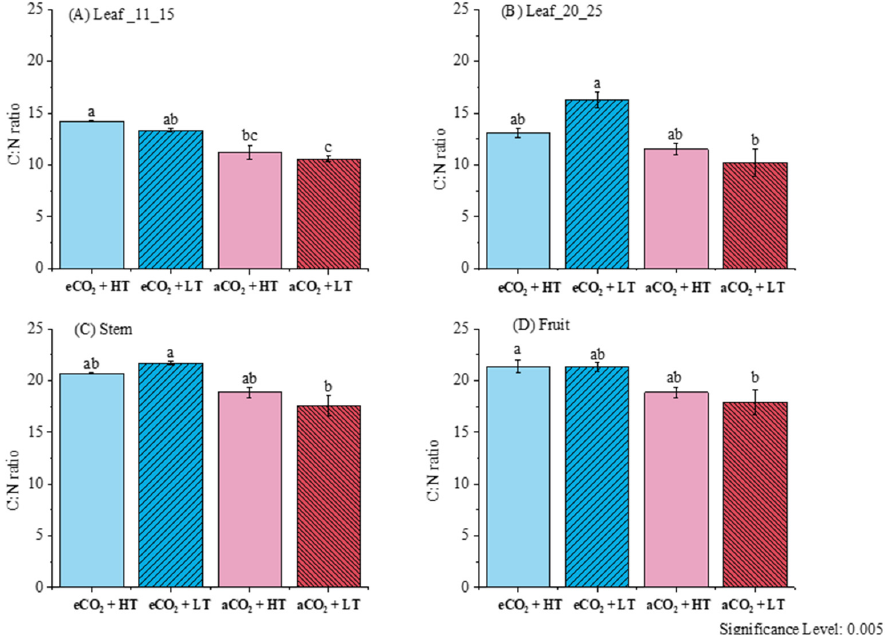
Figure 8. Average C:N ratios of ( A ) developing leaves, ( B ) developed leaves, ( C ) stem, and ( D ) fruit at the end of aCO 2 + LT, aCO 2 + HT, eCO 2 + LT, and eCO 2 + HT treatments. Error bars indicate SE of mean. Different lowercase letters indicate significant differences among treatments ( p < 0.005) .